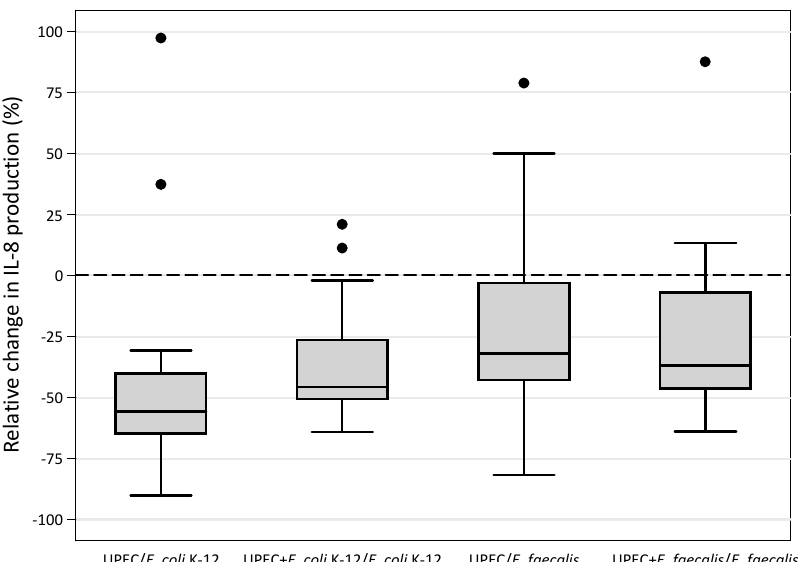
Figure 2. The four indices between values of CXCL8 induced in the 5637 bladder epithelial cell line by fifteen UPEC during in vitro monomicrobial and mixed infections (see Figure 1) displayed as box-plots. The lines inside boxes represent the median value of the observations, and the lower and upper sides of the boxes are the 25th and 75th percentile, respectively. Circles beyond the last bar represent the outliers as they exceed the 75th percentile plus one and half times the interquartile range.